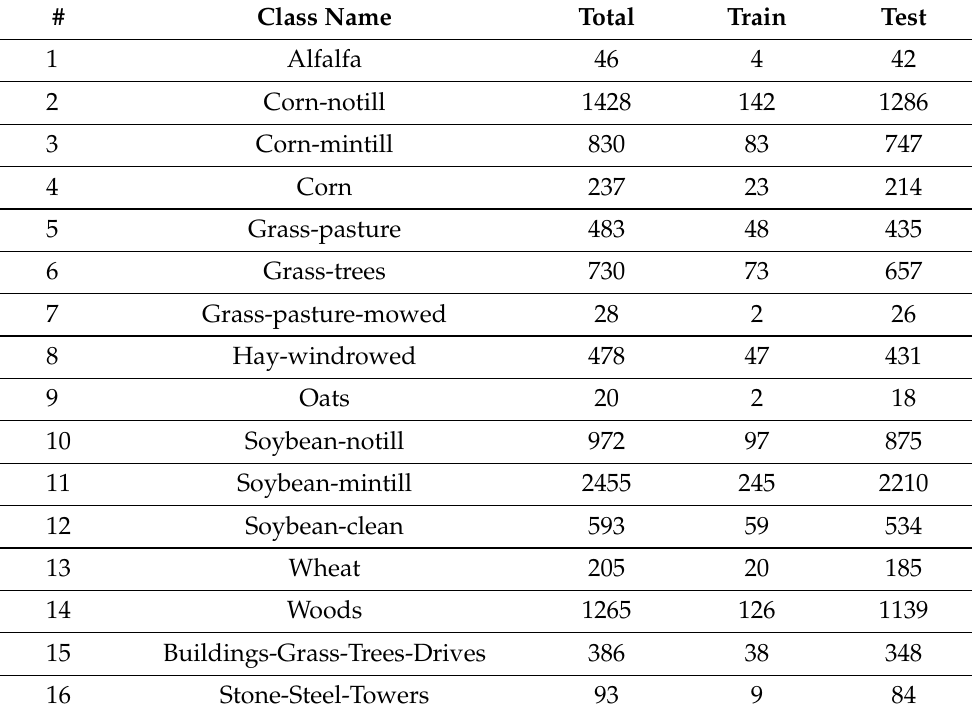
Table 2. Number of train and test sample in the Indian Pines